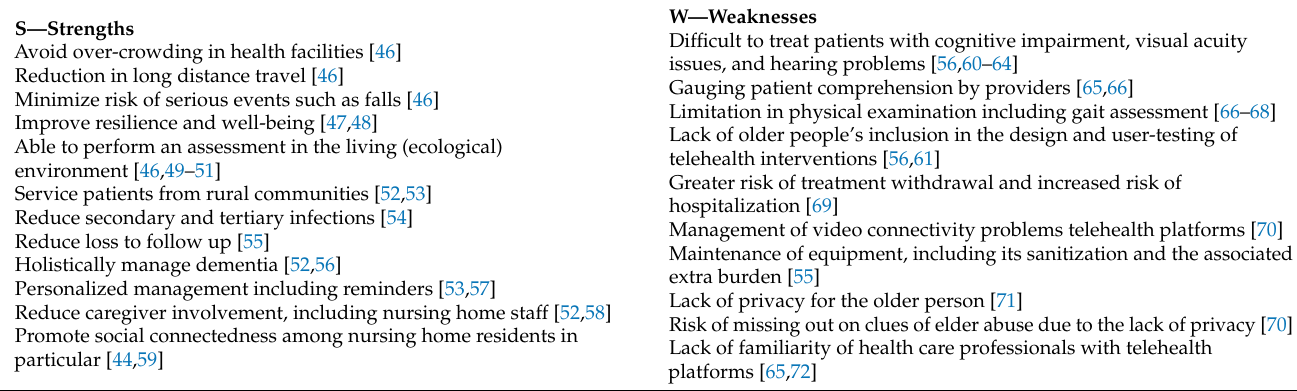
Table 1. The use of telehealth for older people—SWOT